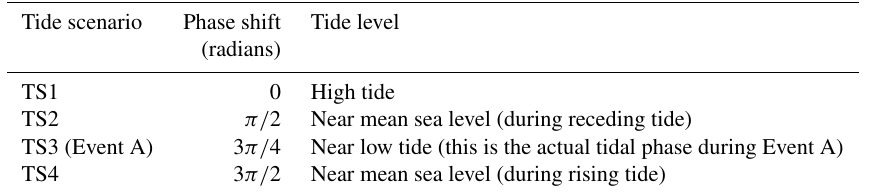
Table 1. Tide scenarios.